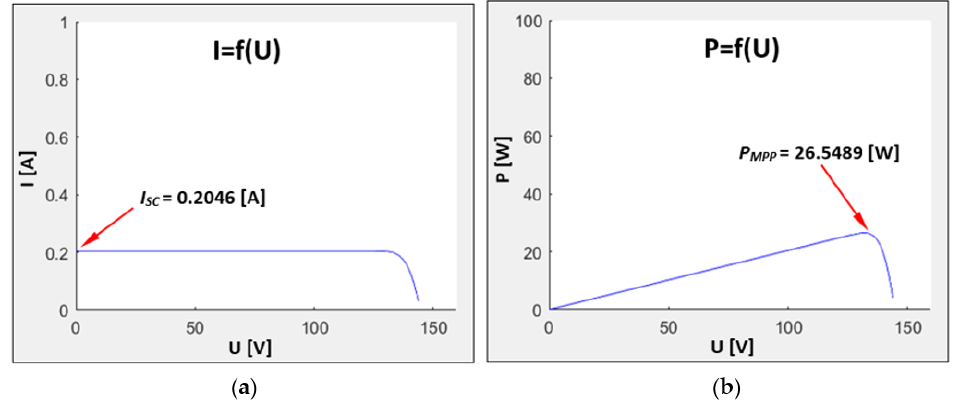
Figure 7. Simulation results for irradiance of 300 W/m 2 deflected by an angle Δ θ = 2° from the direction of perpendicular incidence and a temperature of 21 °C for the modeled CX-75/200 module: